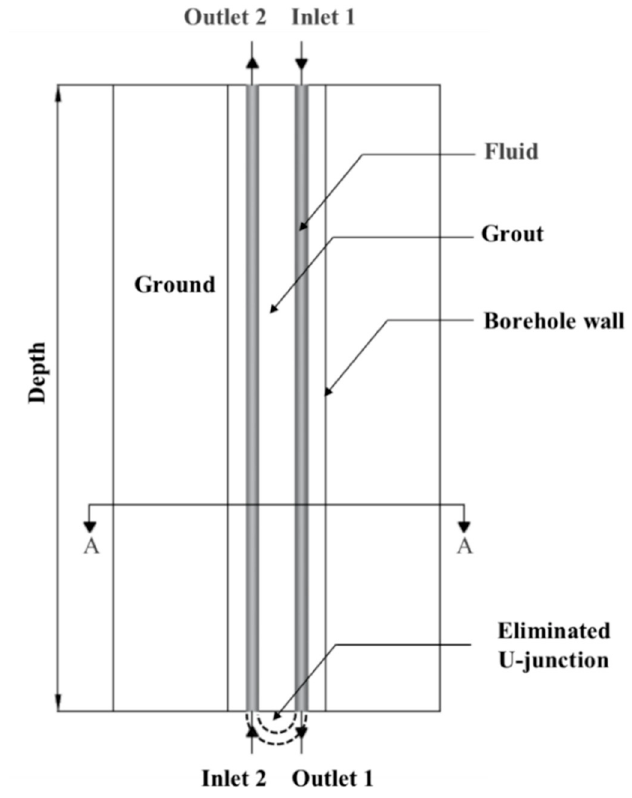
Figure 2. A vertical section through the computational model of the isolated GHE.